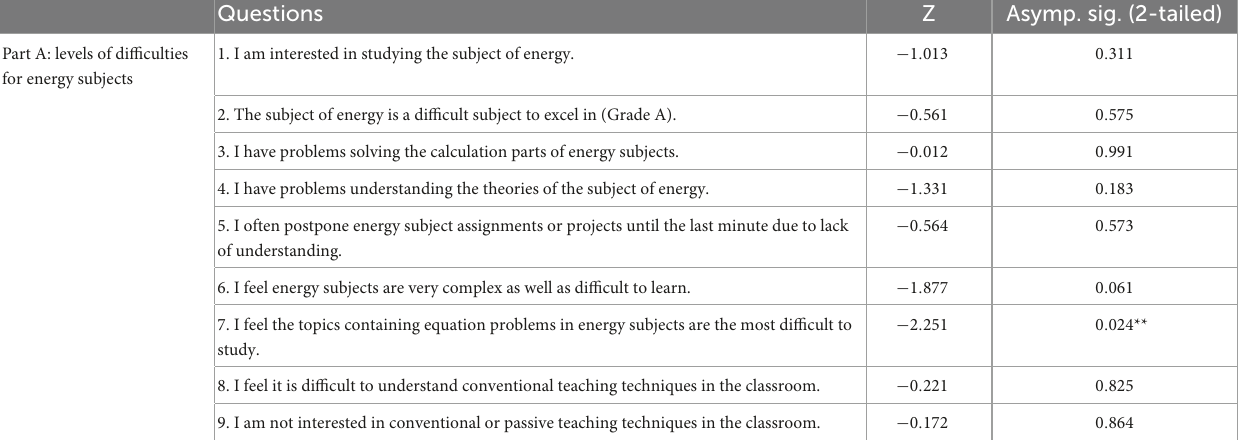
TABLE 2 Non-parametric test using Wilcoxon signed-rank test (Part